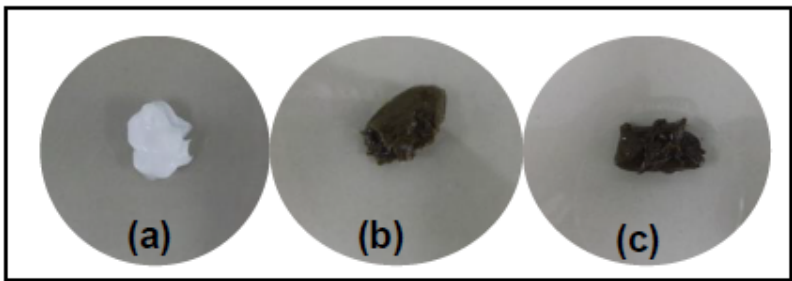
Figure 3. Aspect of base ( a ) and of formulations containing the extract of M. nigra at a concentration of 10% ( b ) and 20% ( c